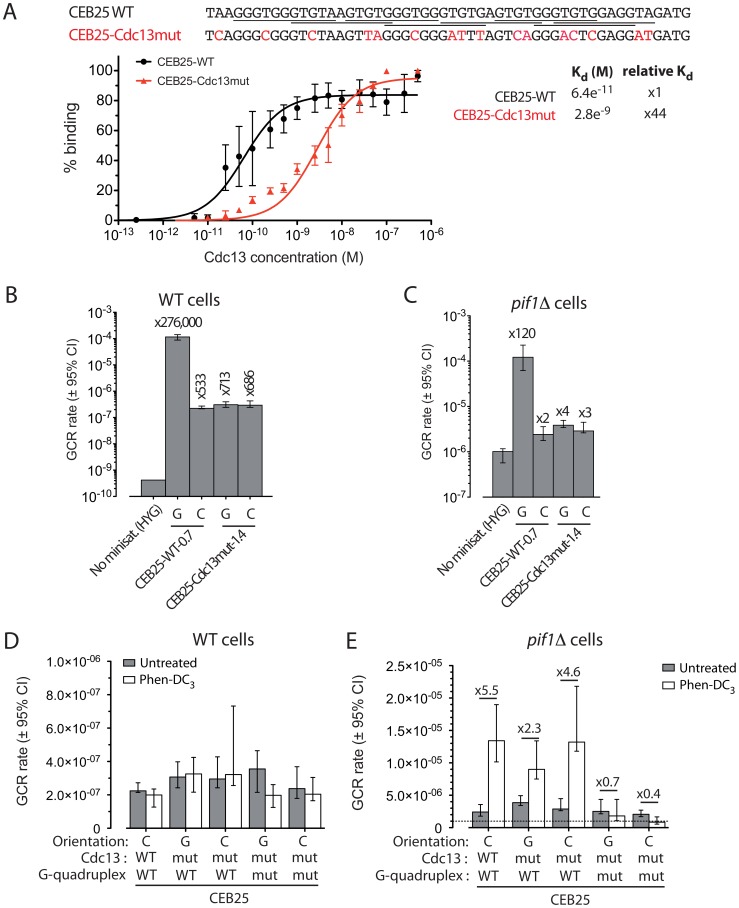
The high rate of GCR induced by CEB25 in an orientation-dependent manner relies on its high affinity Cdc13-binding sites.(A) Analyses of the Cdc13 affinity for CEB25 motifs. The sequences of the CEB25-WT and CEB25-Cdc13mut oligonucleotides used for the gel shift assay experiment are shown. The 11 nt high affinity Cdc13-binding sites (GTGTGGGTGTG, in which the 4 first nucleotides are critical) are underlined [42]. Mutations of the Cdc13-binding sites in CEB25-Cdc13mut are shown in red (16 mutations). The quantification of the proportion of the Cdc13-bound oligonucleotides of CEB25-WT (black) and CEB25-Cdc13mut (red) as a function of the Cdc13 concentration is shown. A second order binomial fit has been applied. Absolute Kd values ± SD and fold difference compared to the CEB25-WT motif are indicated. (B) GCR rates in the control “no minisatellite” WT strain (ORT6531), and WT cells bearing CEB25-WT-0.7 in the orientation G (ORT6558) and C (ORT6556), and CEB25-Cdc13mut-1.4 in the orientation G (ANT1181-1) and C (ANT1180-5). Other legends as in Figure 1C. (C) GCR rates in the control “no minisatellite” pif1Δ strain (ORT6568), and pif1Δ cells bearing CEB25-WT-0.7 in the orientation G (ORT6559-5) and C (ORT6557-1), and CEB25-Cdc13mut-1.4 in the orientation G (ANT1185-4) and C (ANT1184-1). Other legends as in Figure 1D. (D) GCR rates in WT cells bearing CEB25-WT-0.7 in the orientation C, CEB25-Cdc13mut-1.4 in the orientation G and C, or CEB25-Cdc13mut-Gmut-1.4 in the orientation G and C treated with 10 µM Phen-DC3 (white) or not (grey). (E) GCR rates in pif1Δ cells bearing CEB25-WT-0.7 in the orientation C (ORT6557-1), CEB25-Cdc13mut-1.4 in the orientation G (ANT1184-1) and C (ANT1185-4), or CEB25-Cdc13mut-Gmut-1.4 in the orientation G (ANT1187-1) and C (ANT1186-1) treated with 10 µM Phen-DC3 (white) or not (grey).